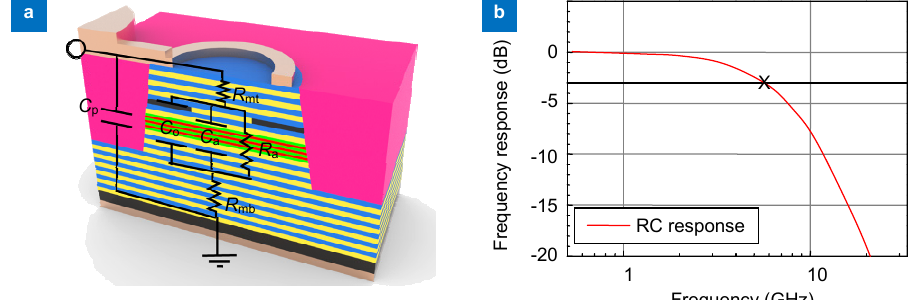
Fig. 2 | ( a ) Electrical parasitic elements inside a VCSEL. ( b ) Low pass filter induced by the RC components.